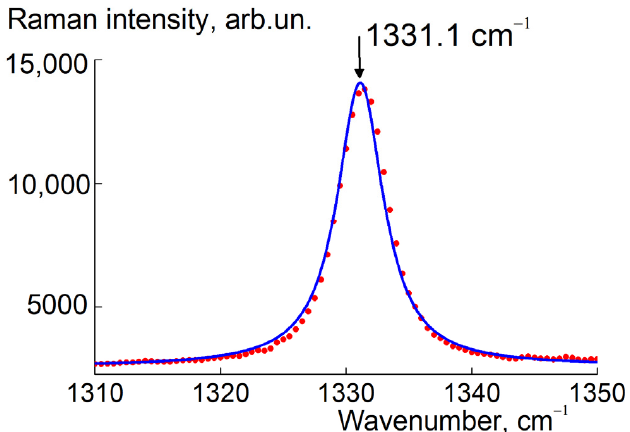
Figure 10. Raman spectrum for the purified sample SEu3 (dots). Lorentzian fitting (solid line) shows a characteristic diamond peak with maximum at 1331.1 cm -1 .